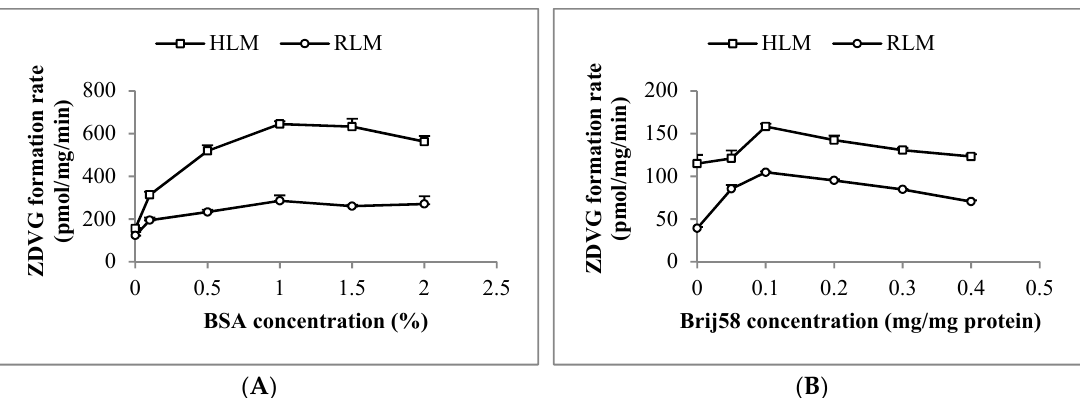
Figure 2. Optimization of ( A ) bovine serum albumin (BSA) and ( B ) polyethylene glycol hexadecyl ether (Brij58) concentration in incubation with human (HLM) and rat liver microsomes (RLM). Each point represents the mean of zidovudine glucuronides (ZDVG) formation rate ± standard deviation (SD) for triplicates ( n = 3). Table 4. Derived kinetic constants for zidovudine glucuronidation in human (HLM) and rat liver microsomes (RLM) obtained from the incubation with and without 1% ( w / v ) bovine serum albumin (BSA). Data are presented as mean ± SD.